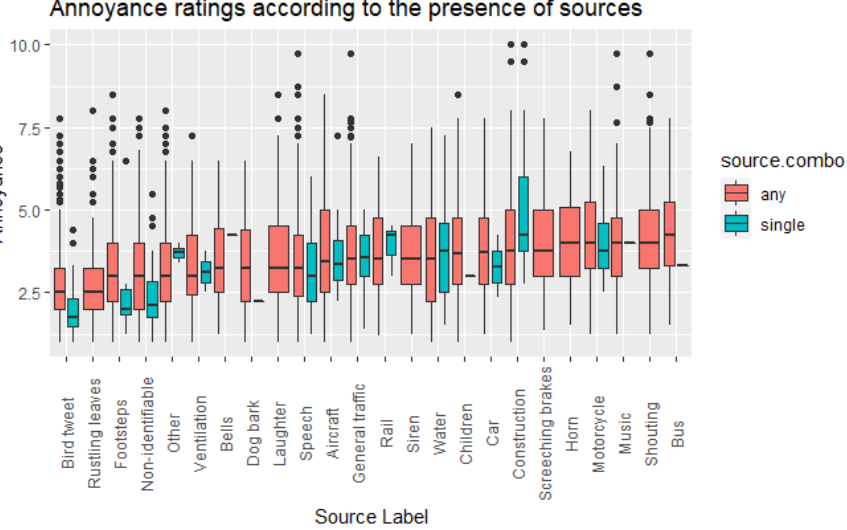
Figure 6. Box plots of the Annoyance scores as a function of sound source presence, either on its own (“single”) or in combination with other sources (“any”), including the “other” and “non-identifiable” labels; box width represents relative sample size.